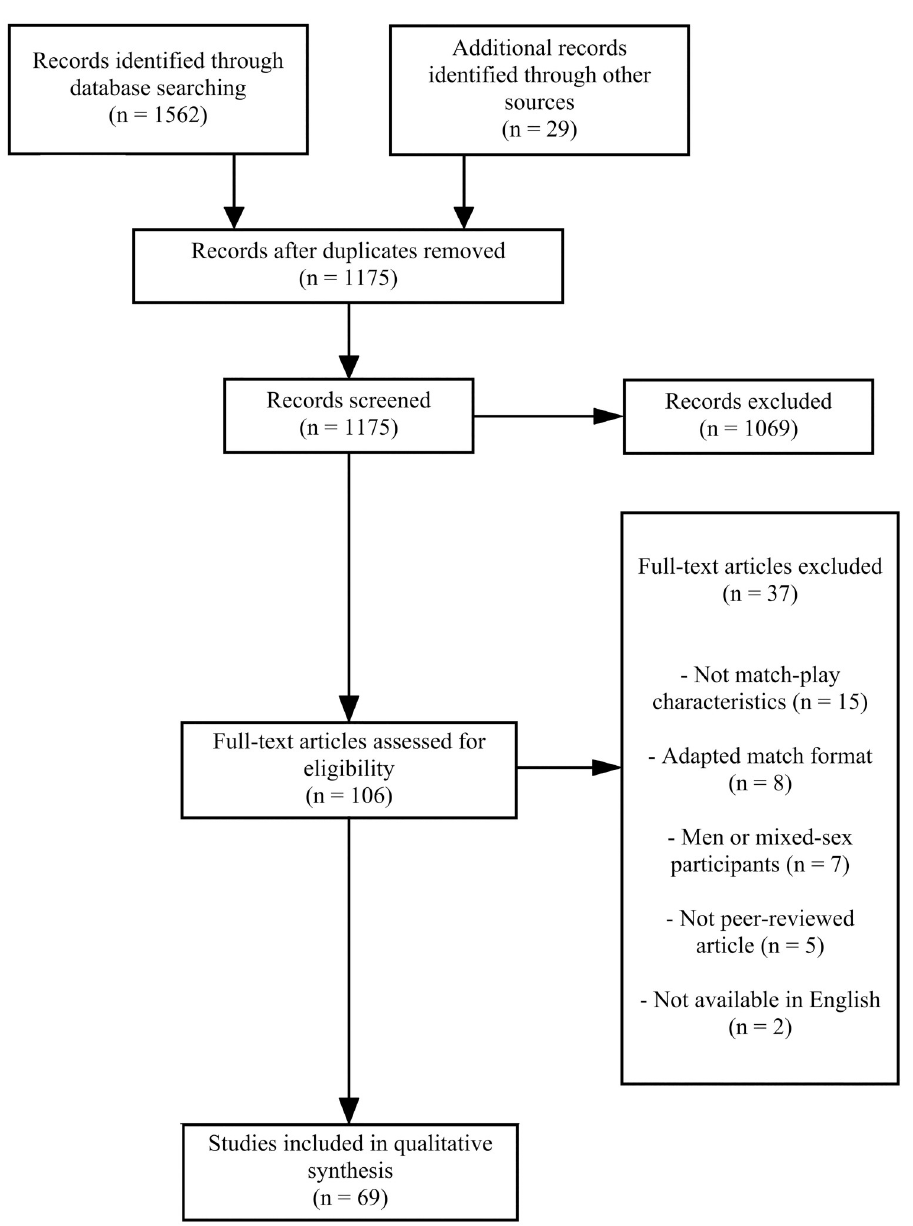
Fig 1. Flow diagram of study selection process for qualitative